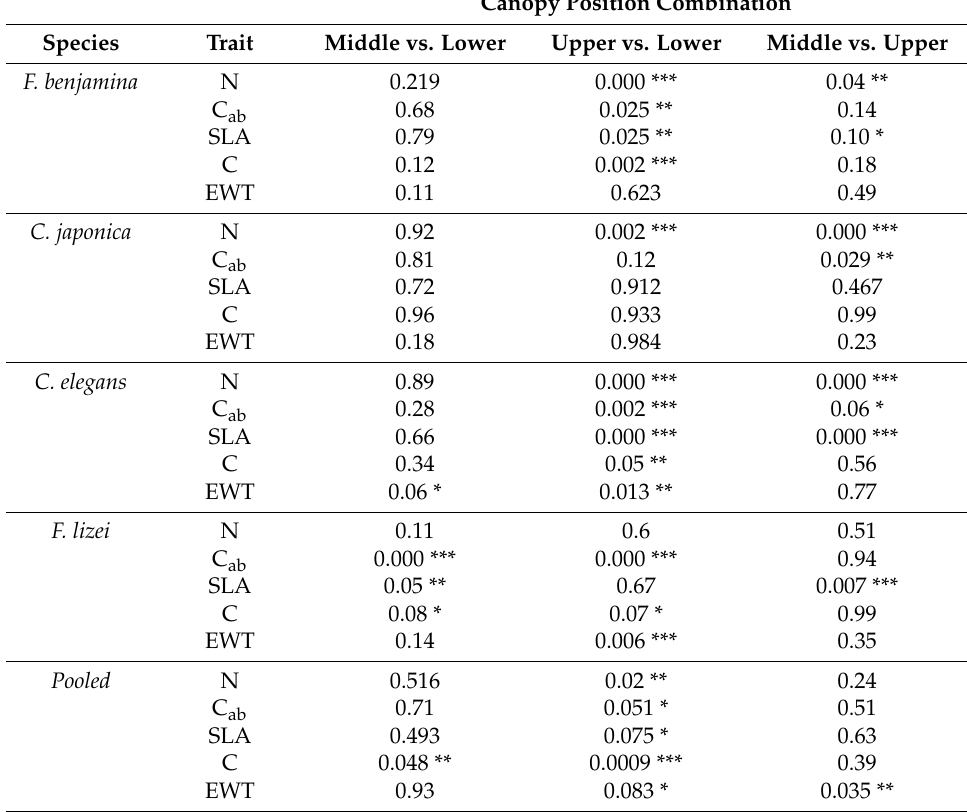
Table 2. Summary of pairwise variation in leaf traits per species and within pooled data per each canopy position pair. Significant p -value at 0.1 *, 0.05 ** and 0.01 *** are indicated. Canopy Position Combination Trait Middle vs. Lower